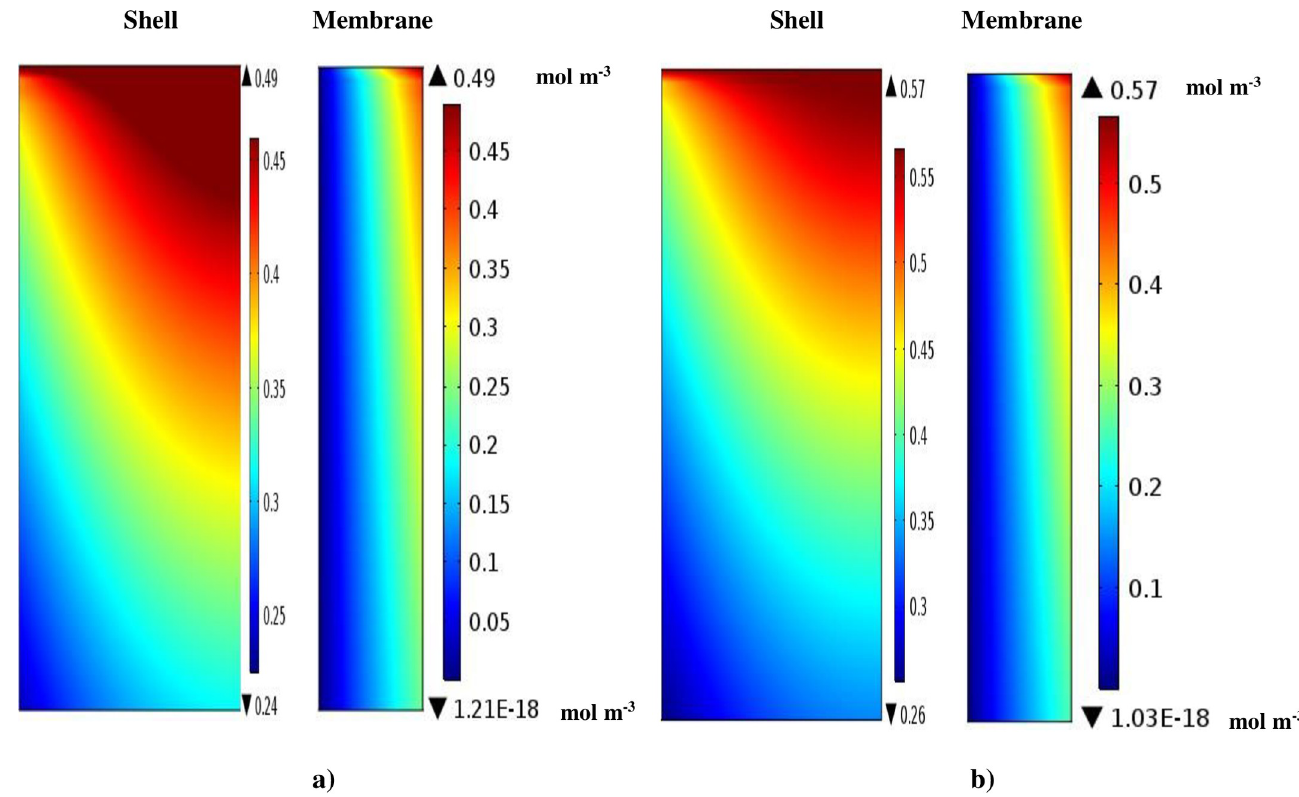
Fig 4. Concentration gradient of a) ibuprofen and b) isobutylacetophenone solutes inside the shell and the membrane sections of the PMC.